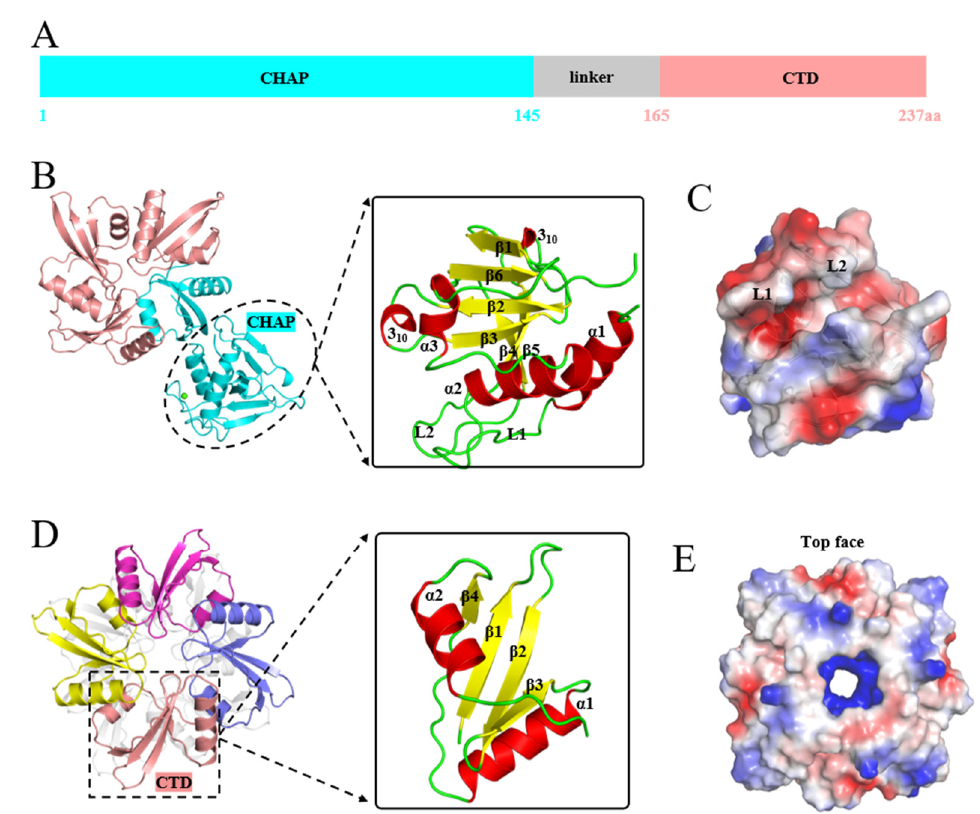
Figure 2. Three-dimensional structures of EFm1 D166Q and EFm1 166–237 aa . ( A ) Domain organization of EFm1; ( B ) Structure of EFm1 D166Q including the NTD (1–165 aa), the CTD (165–237 aa) and a putative linker (145–165 aa); ( C ) Electron density maps of the CHAP domain; ( D ) Structure of EFm1 166–237 aa ; ( E ) Electron density map of EFm1 166–237 aa .